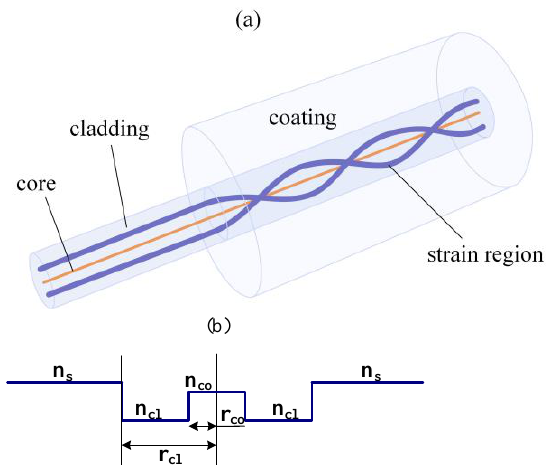
Figure 1. Theoretical model of coated CLPG. ( a ) Sketch of CLPG formed by twisting a panda fiber and coated with a high-RI material; ( b ) index profile of CLPG.